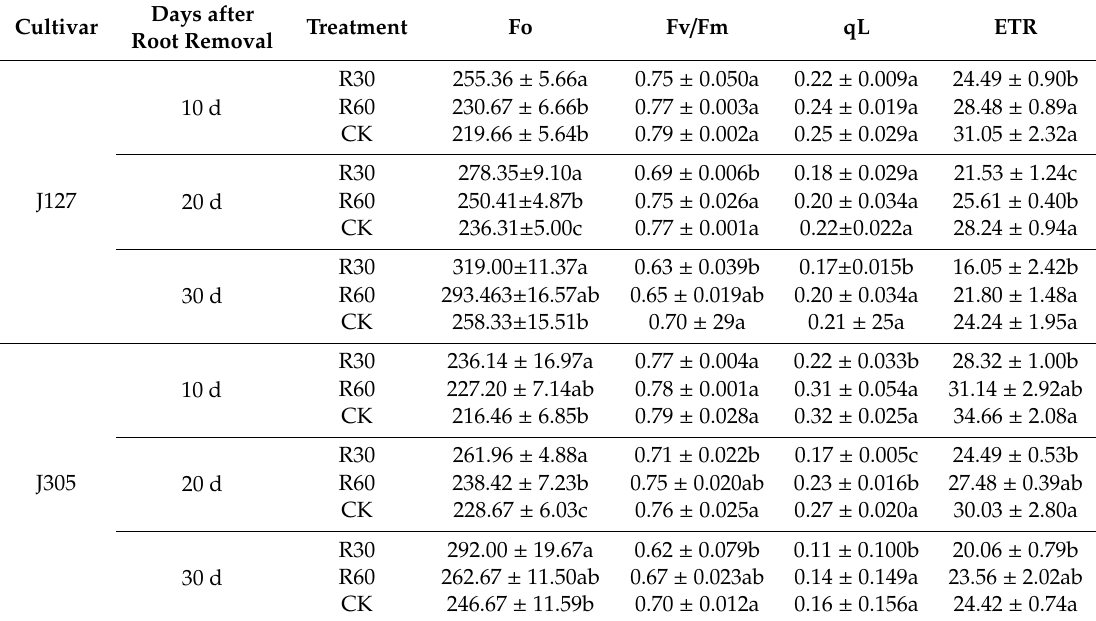
Table 2. E ff ects of root removal in di ff erent soil depths on fluorescence parameters. Cultivar